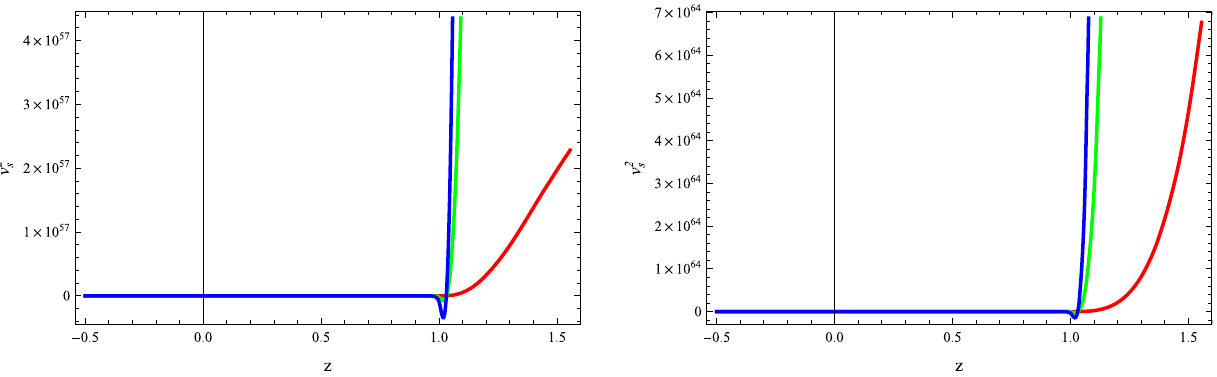
Fig. 10 Plots of unified phases v 2 s for u = 2 (left) and − 2 (right). Also, H 2 = 2 . 7 (red), H 2 = 2 . 75 (green) and H 2 = 2 . 8 (blue)